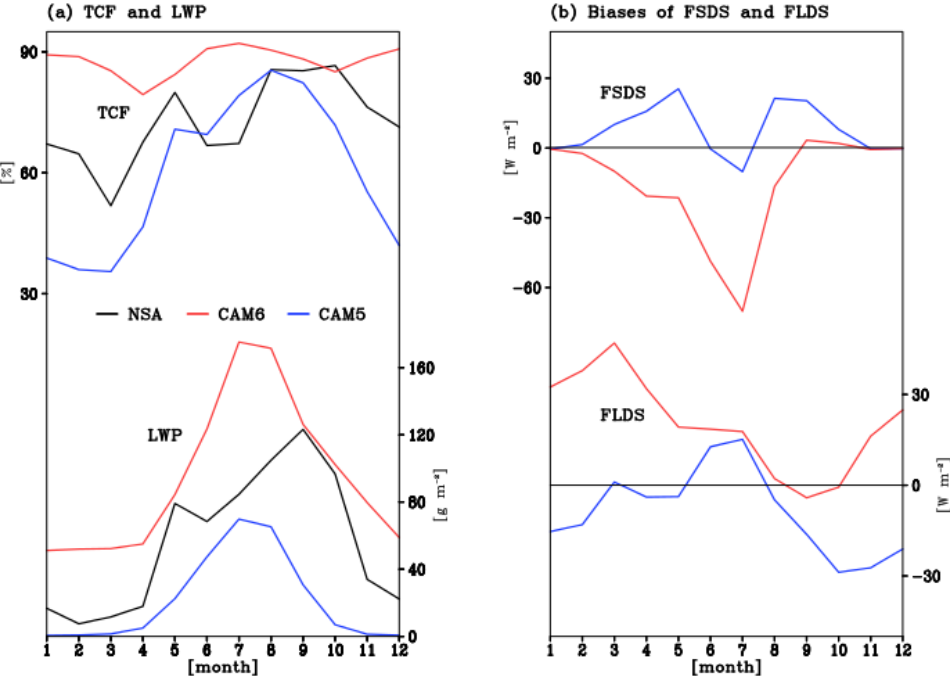
Figure 4. Annual cycles of total cloud fraction (TCF), upper part in ( a ) and liquid water path (LWP), bottom part in ( a ) from the climatology of ground-based cloud and radiation measurements at the North Slope of Alaska (NSA) Barrow site (black line), CAM6 (red line), and CAM5 (blue line). Biases of surface downward SW flux (FSDS), upper part in ( b ) and surface downward longwave flux (FLDS), bottom part in ( b ) of SAM0 (red line) and CAM5 (blue line) against the climatology of ground-based cloud and radiation measurements at the NSA Barrow